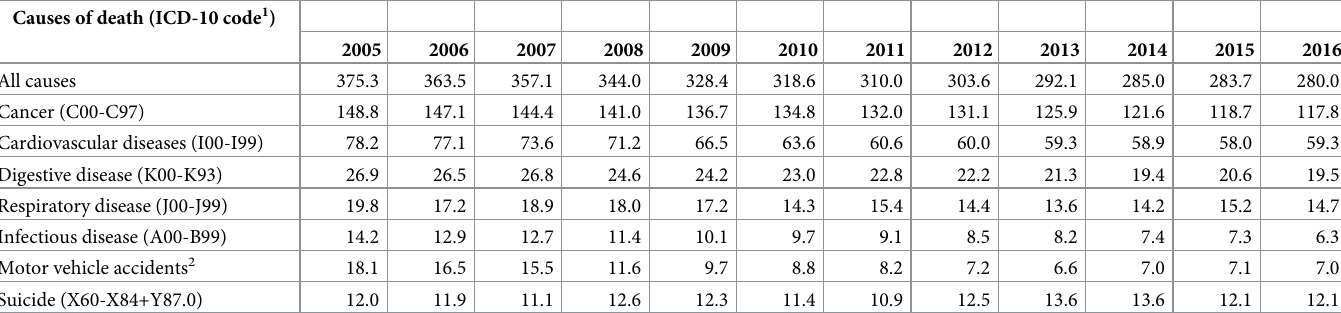
Table 1. Age-adjusted annual mortality rate per 100,000 people by cause of death in the Spanish men aged 15 to 64 years, 2005–2016. Causes of death (ICD-10 code 1